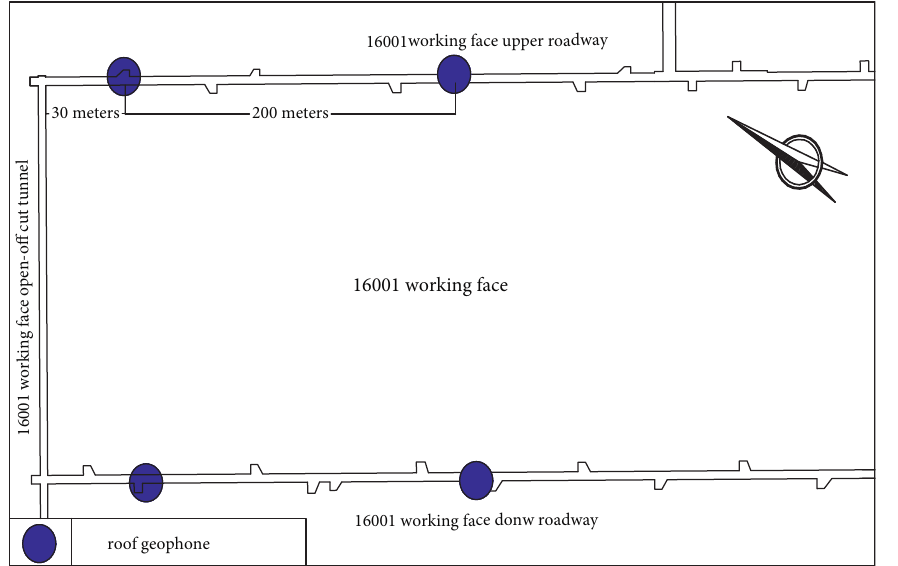
Figure 5: Plan of initial geophone layout. Table 2: Roof strata of the coal